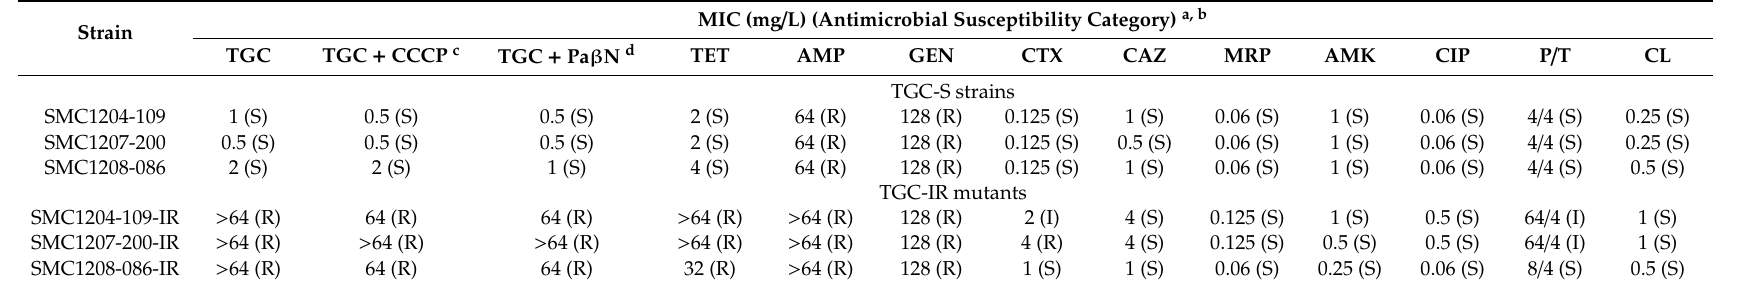
Table 2. Antimicrobial susceptibility profiles of Klebsiella pneumoniae strains used in this study.